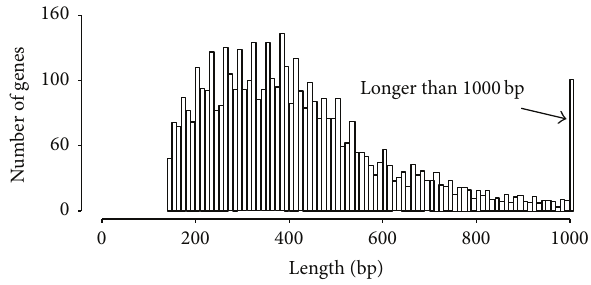
Figure 1: Length distribution of sequence alignments for the ortholog groups among C. azalea , C. sinensis , and C. oleifera